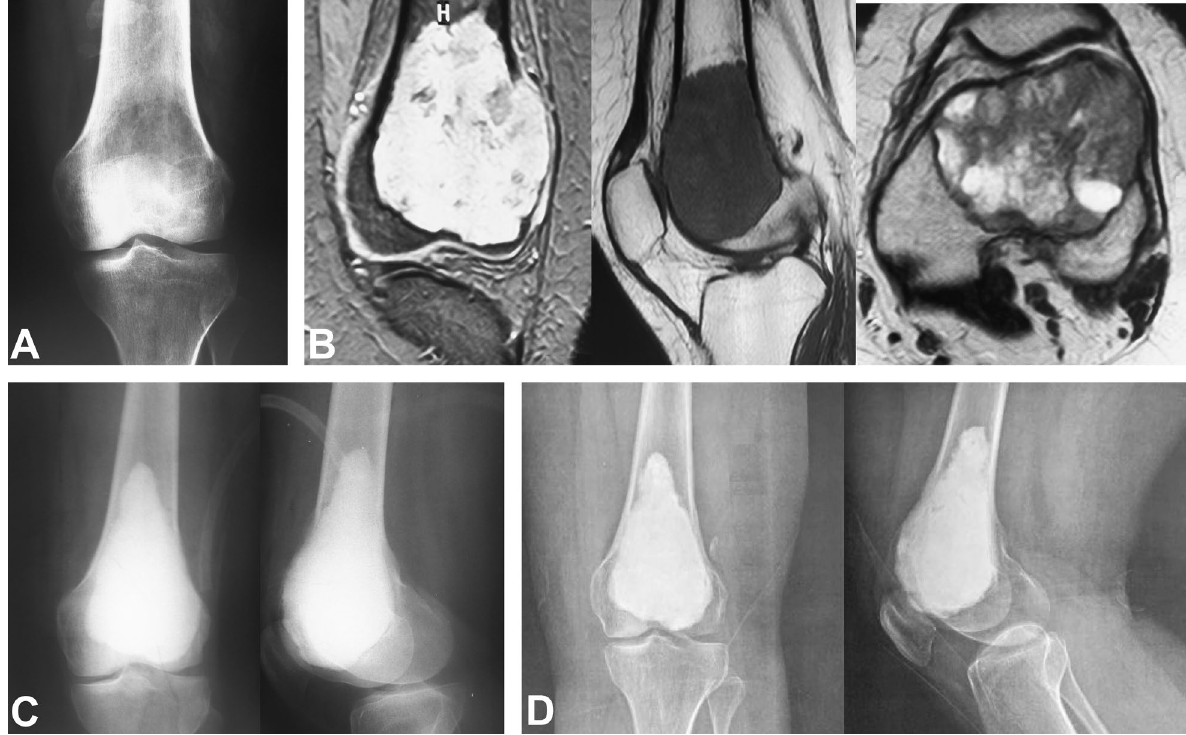
Fig. 2 A 25-year-old female with giant cell tumor of the distal femur treated with curettage and cementation. A Preoperative AP X-ray. B Preoperative coronal, sagittal, and axial MRI cuts. C Immediate postoperative AP and lateral X-rays. D Ten-year follow-up AP and lateral X-rays with KL grade